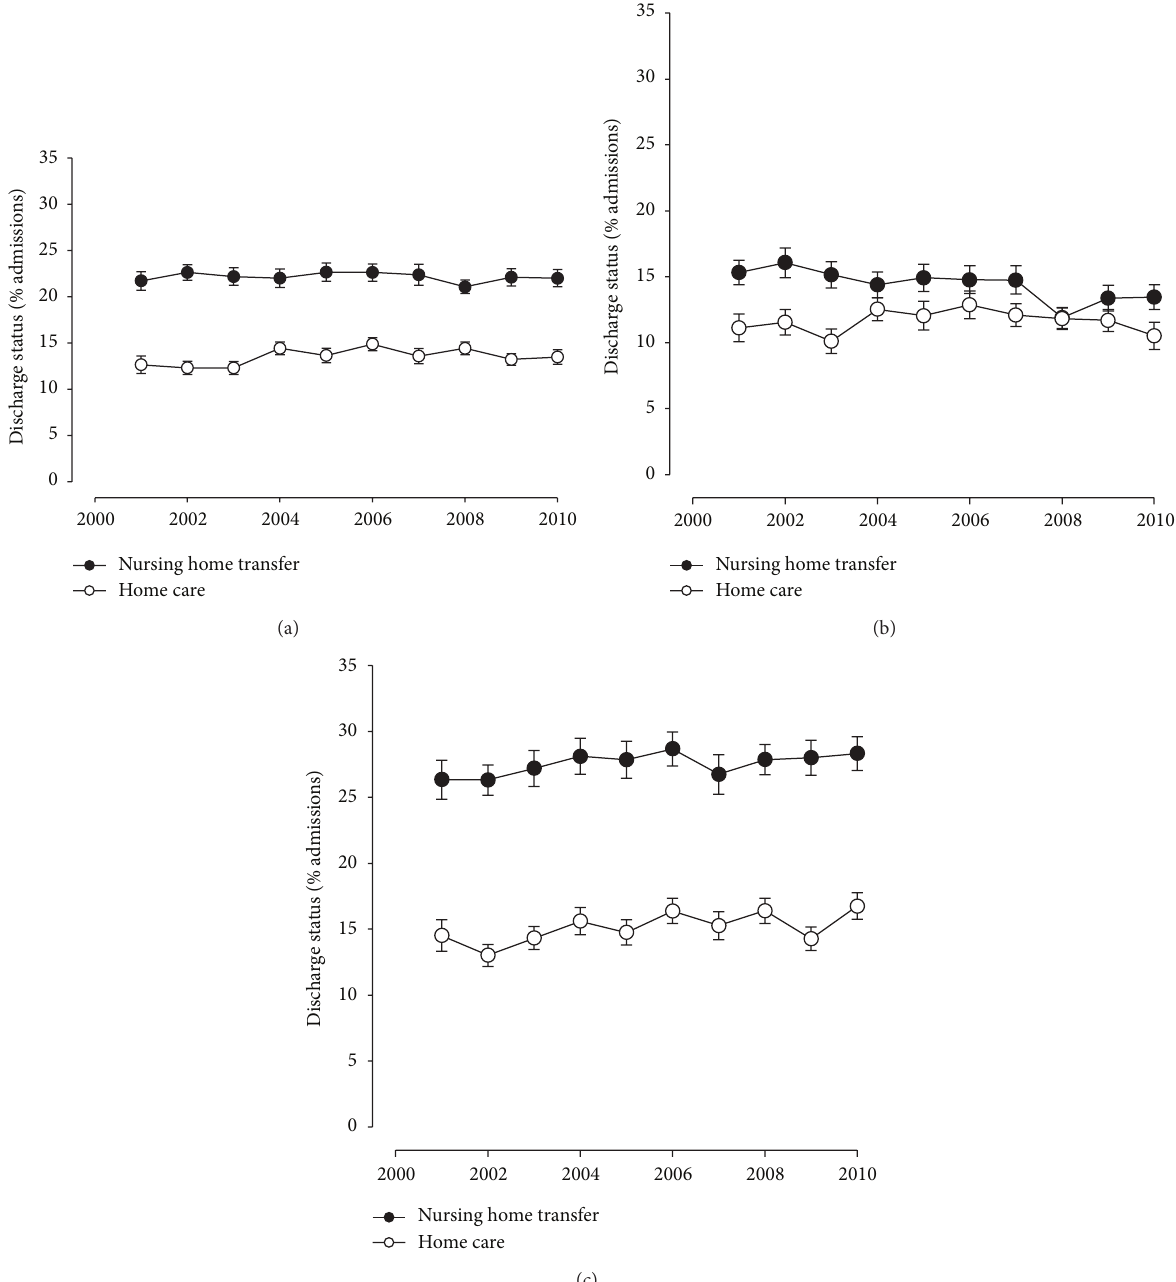
Figure 2: Time-dependent changes in discharge status as surrogate measures of functional impairment: nursing home transfers and discharge to ongoing home care are plotted for all the admissions with MS (a), admissions of patients 18–44 years (b) and 45–64 years